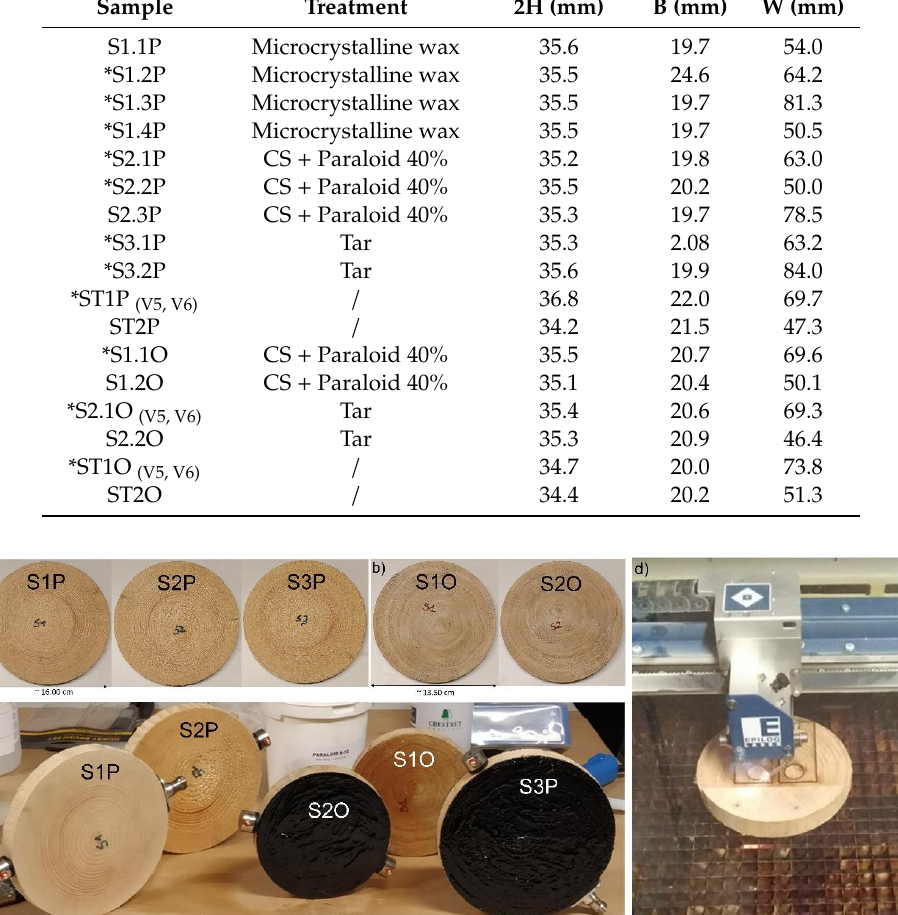
Table 1. Dimensions of the simil-CT pine and oak samples. Samples marked with an asterisk have been considered for calibration curve elaboration. P, pine; O, oak; (V5), vallen sensor number 5. In the sample nomenclature, the meaning of the characters are as follows: S, sample; 1, 2, and 3, treatment type, i.e., Reinnassence wax, CS + Paraloid, and tar; 1 to 4, number of the tested sample with that specific treatment; last character P or O, pine and oak; H, height of the specimen; B, thickness of the specimen; W, length of the specimen. * Samples with BL calibration curves.